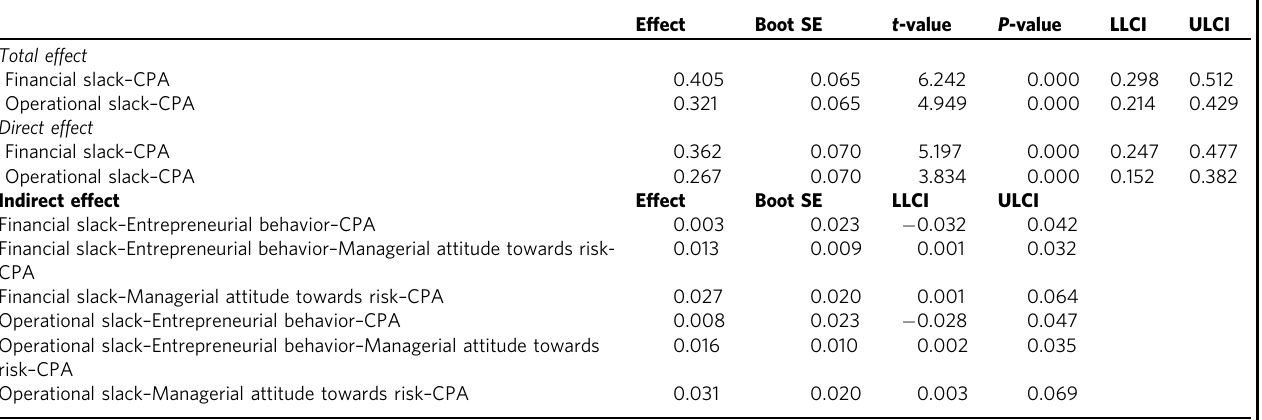
Table 5 Results of